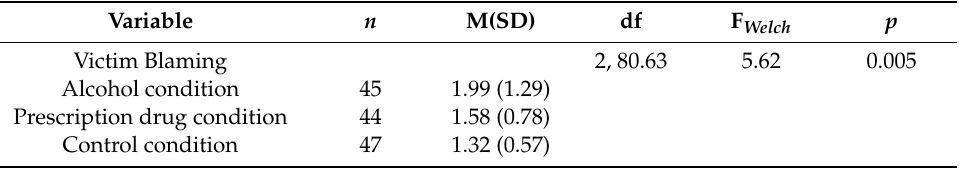
Table 1. Descriptive statistics and ANOVAs for victim